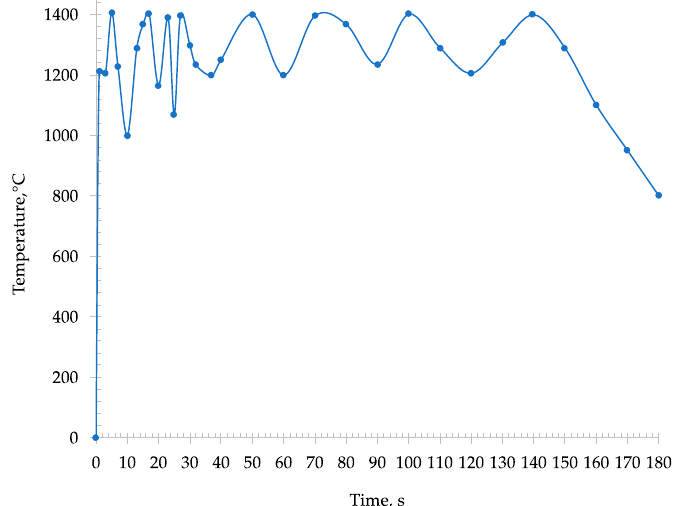
Figure 10. Heating rates of 3rd MW roasting process at 0.6 kW, 1 L/min N 2 flow constant and 180 s. After 180 s, a drastically reduction of T was detected from the pyrometer (Figure 10) [2,10] and the experiments were stopped as the tablet reflected the microwave energy due to the increased concentration of conductive material (such as metallic